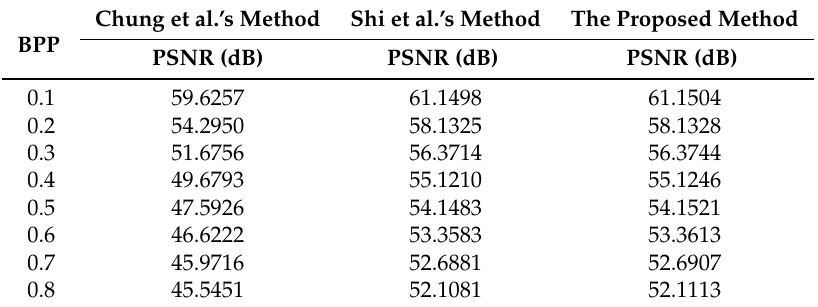
Table 1. The comparision of the PSNR at the different BPP for the depth map, “Shark”. Chung et al.’s Method Shi et al.’s Method The Proposed